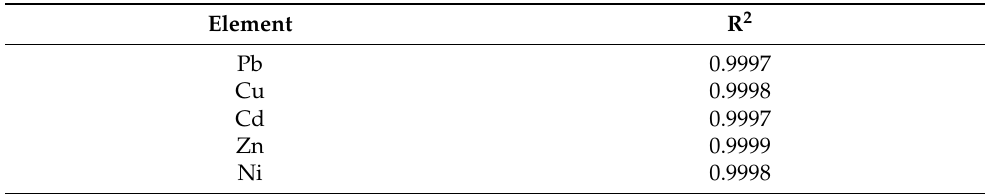
Table 1. R 2 values of each heavy metal.